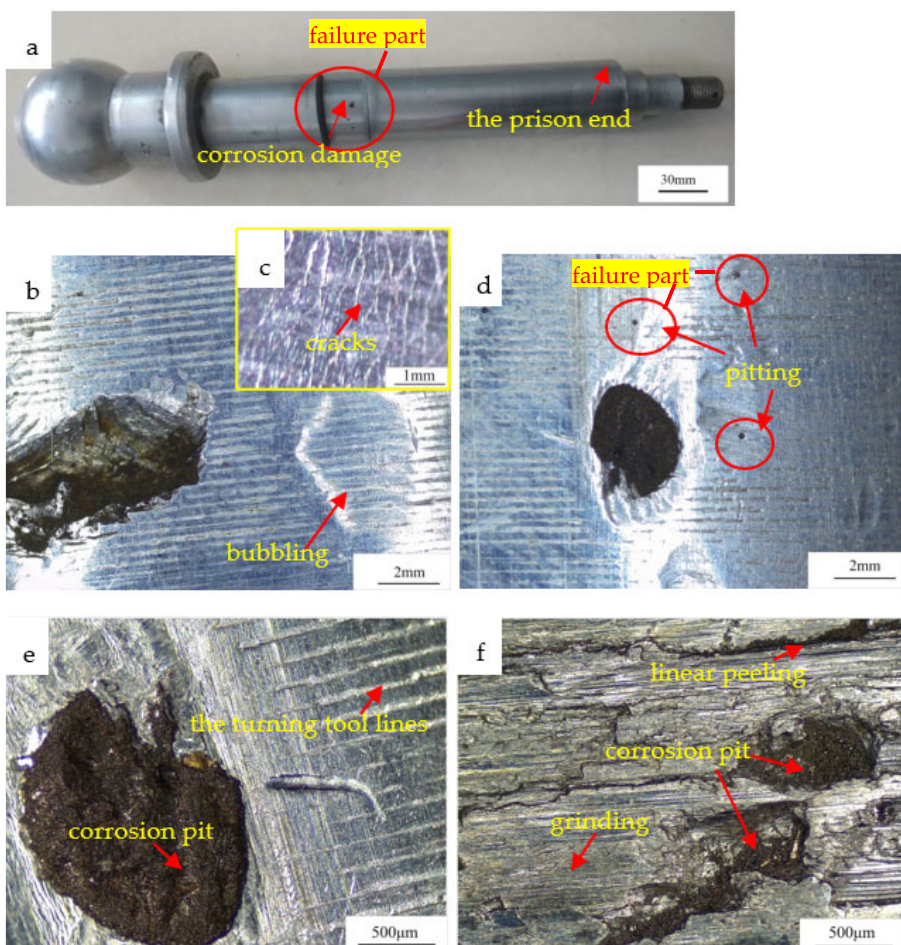
Figure 2. Macroscopic morphology observation: ( a ) piston rod; ( b ) bubbling of the chromium plating layer; ( c ) magnified surface of bubbling; ( d ) pitting; ( e ) corrosion pit; ( f ) grinding and peeling.